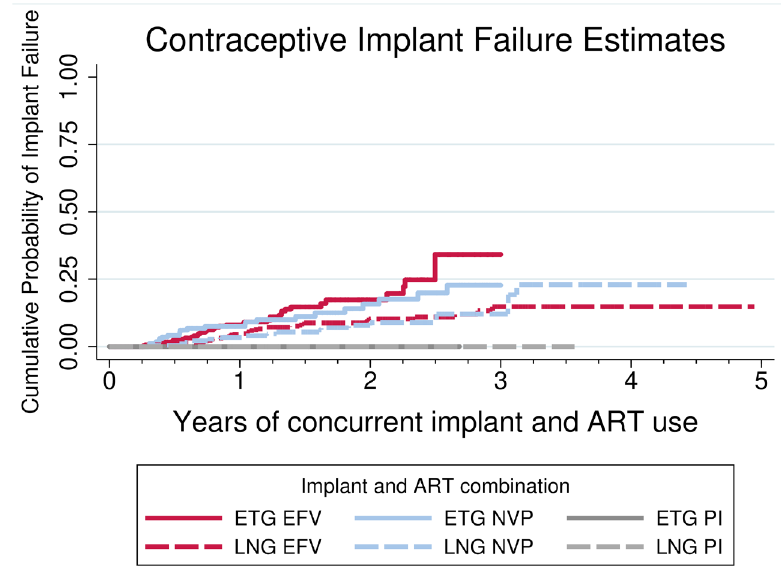
Figure 1. Contraceptive implant failure estimates. ART, antiretroviral therapy; NVP, nevirapine; EFV, efavirenz; ETG, etonogestrel; LNG, levonorgestrel; PI, protease